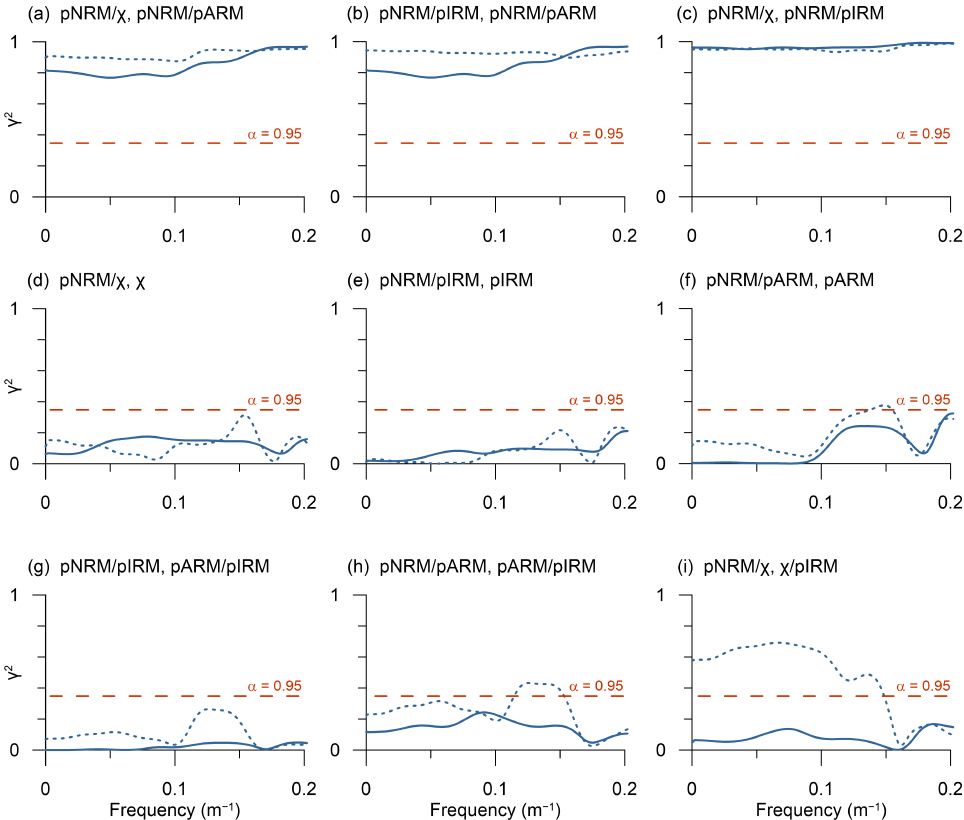
Figure 5. Squared coherence γ 2 between RPI proxies and rock magnetic parameters for the whole depth range (dashed blue lines), for > 6.7mc.d. (solid blue lines), compared to the 95% confidence level threshold (dashed red lines). (a–c) Squared coherence between RPI proxies. (d–f) Squared coherence between RPI proxies and the corresponding NRM normalizer. (g–i) Squared coherence between RPI proxies and magnetic grain size